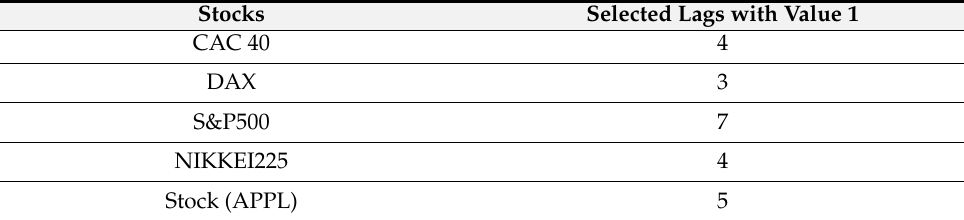
Table 10. Number of selected lag features from each stock index according to the chromosome selected from Table